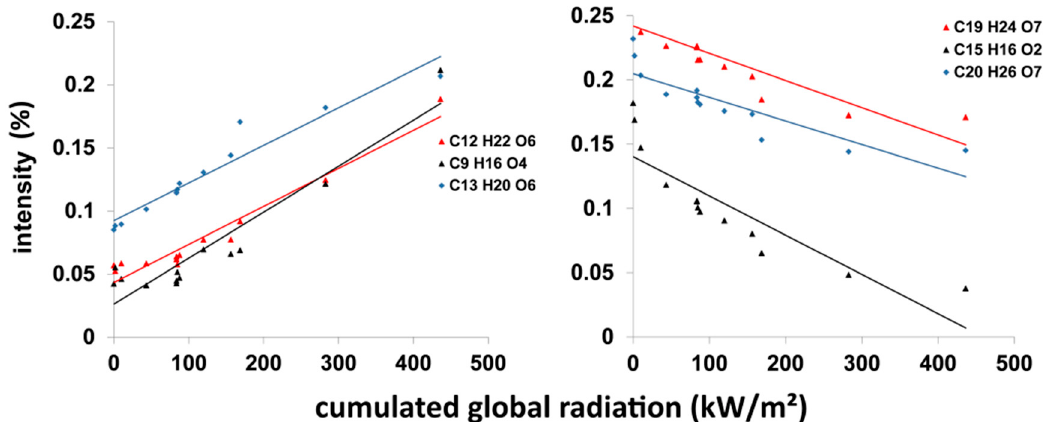
Figure 1. Linear regression of normalized intensity (%) of specific molecular formulas over the cumulated global radiation (kW/m 2 ) as an example.